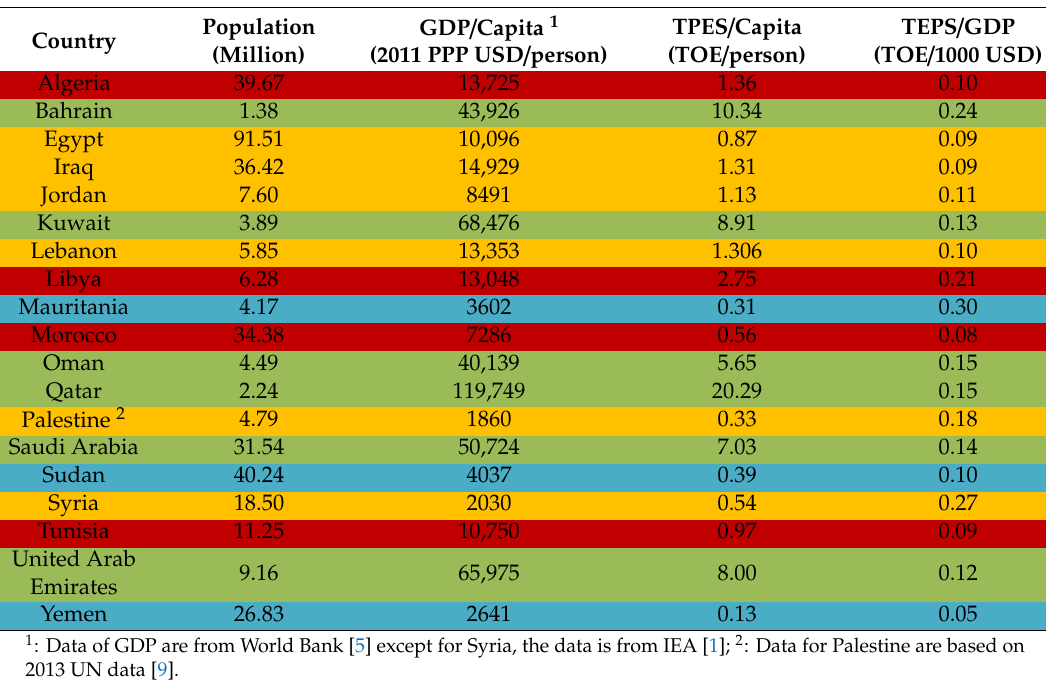
Table 2. Summary of basic macro-economic indicators for Arab countries for 2015 (colors refer to the sub-regions: green for GCC, yellow for Mashreq, maroon for Maghreb, and blue for LDC).